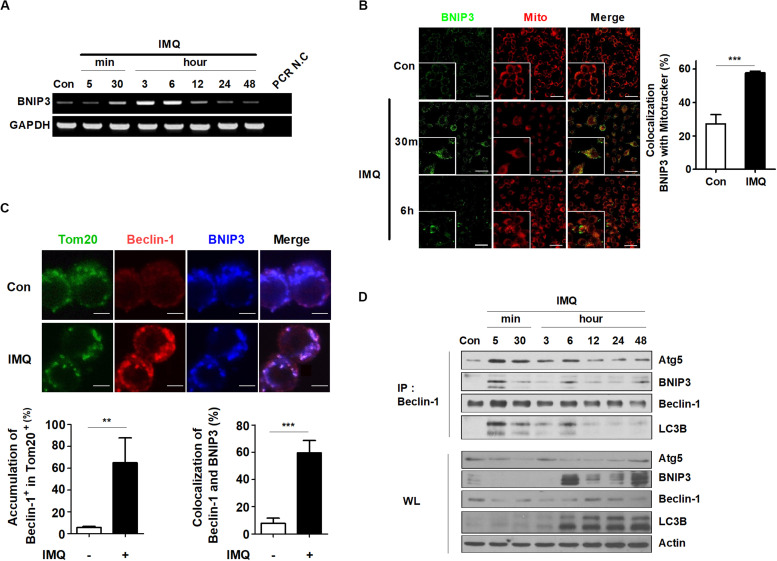
BNIP3 is recruited to the mitochondria and associated with beclin-1 in IMQ-treated macrophages. (A) mRNA expression of BNIP3 was detected by RT-PCR in IMQ-treated cells. (B) The overlapping signal between MitoTracker Red (mito) and BNIP3 was observed by confocal microscopy at 30 min and 6 h in IMQ-treated cells. The bar graph represents the percentage of MitoTracker Red overlapping with BNIP3. (C) Raw264.7 cells were treated with IMQ for 30 min and fixed and stained with anti-Tom20, anti-beclin-1 and anti-BNIP3 antibodies. The overlapping signal of these proteins was detected by confocal microscopy. Bar graphs represent the percentage of beclin-1 accumulation in Tom20+ mitochondria and beclin-1 overlapping with BNIP3. (D) Total cell lysates were immunoprecipitated with anti-beclin-1 and analyzed by Western blotting using antibodies against BNIP3, Atg5, beclin-1, LC3B, and actin. Data are the means ± s.d. of three technical replicates and are representative of at least three independent experiments. Images are representative of at least three independent experiments. Statistical significance is indicated as **p < 0.01 and ***p < 0.001.